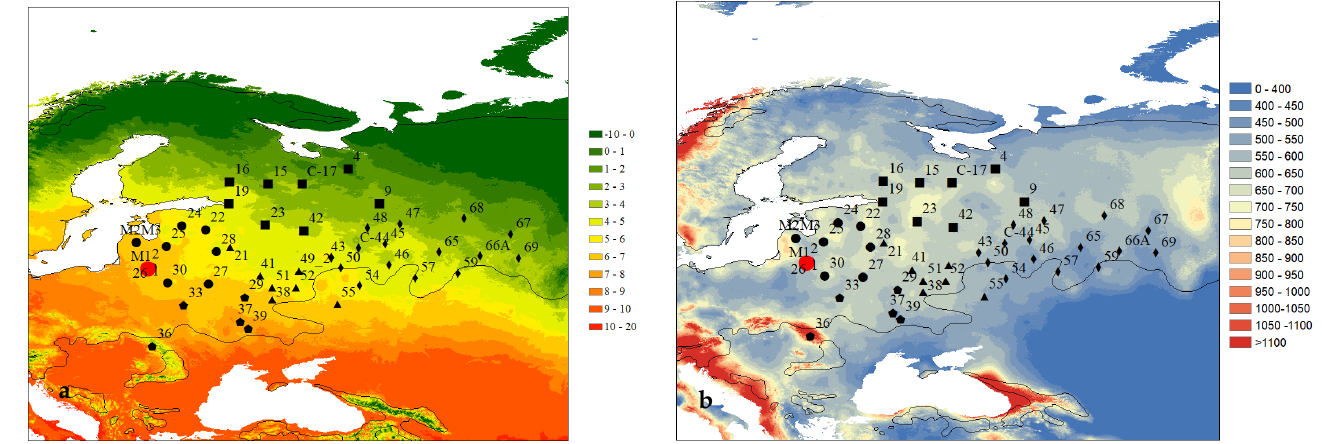
Figure 1. Location of study area (red circle) and places of origin of analyzed provenances (colored triangles). Colors of the maps show: ( a ) mean annual temperature and ( b ) annual precipitation for 1970–2000 period. Climatic maps were provided by WorldClim 2—Global Climate Data website (https://www.worldclim.org/data/worldclim21.html, accessed on 25 April 2022 [34]). The shapes of symbol indicate Scots pine provenances from: diamonds—eastern, triangles—central, squares—northern, pentagons—southern, and circles—western locations that were created by using principal component analysis. The black line indicates distribution range of Scots pine (shapefiles taken from Caudullo et al. [35]).